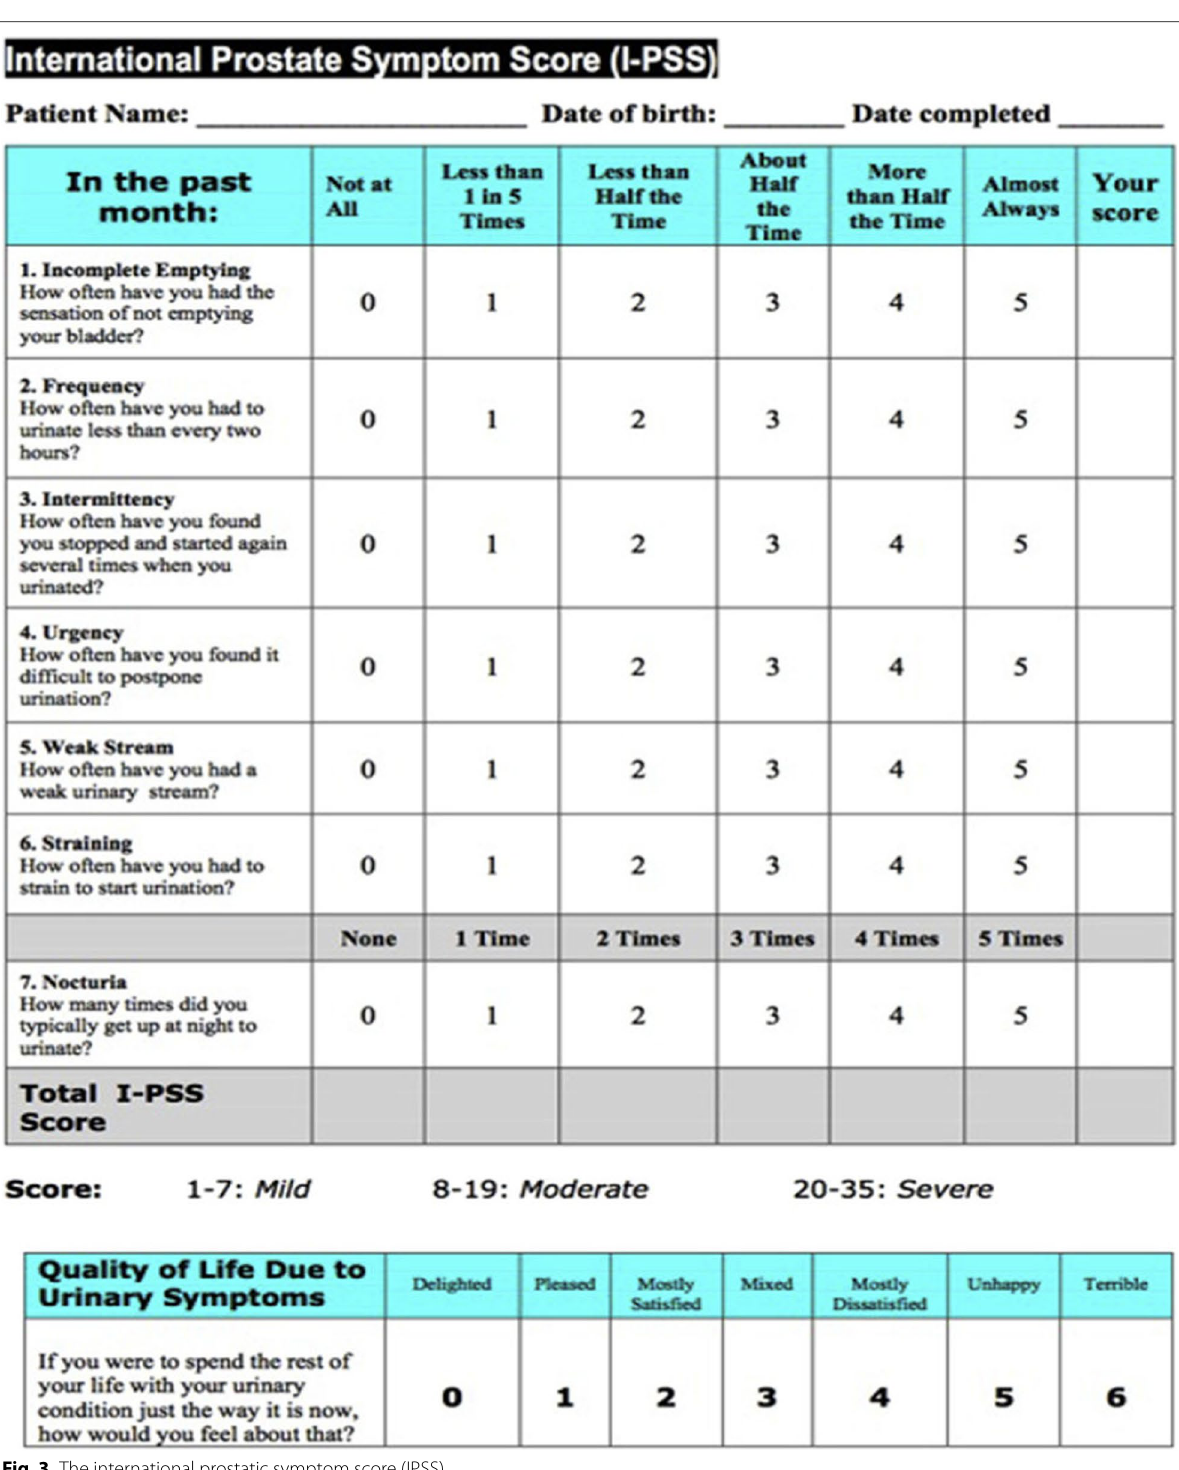
Fig. 3 The international prostatic symptom score